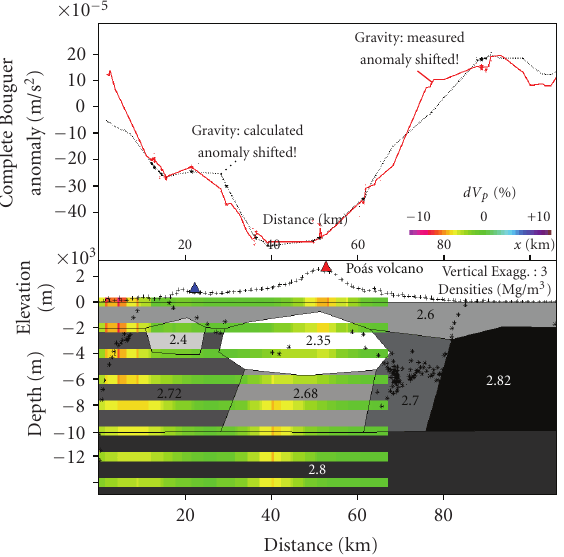
Figure 7: 3D density model cross section across the Po´as volcano and surrounding regions. Red and black curves in the upper box show the measured and calculated gravity anomalies, respectively. Black plus-signs indicate topography derived from SRTM 3 arc sec grid which is projected on the cross section; black stars in the lower box show Euler source points. Grayscale polygons represent modeled crustal bodies with corresponding densities. Colored pixels and bars show percentage of change in V p velocities which were calculated by Arroyo [13]. Red triangle indicates the location of the main Quaternary volcanic vent; blue triangle indicates the locations of inferred paleo-volcanic vent.